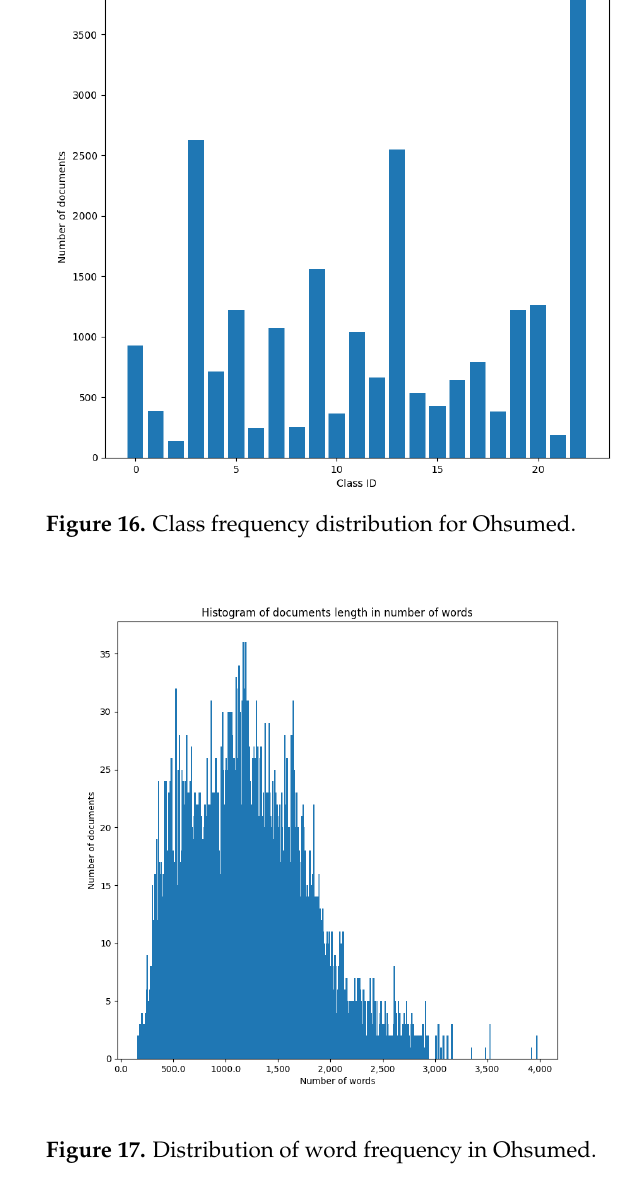
Figure 17. Distribution of word frequency in